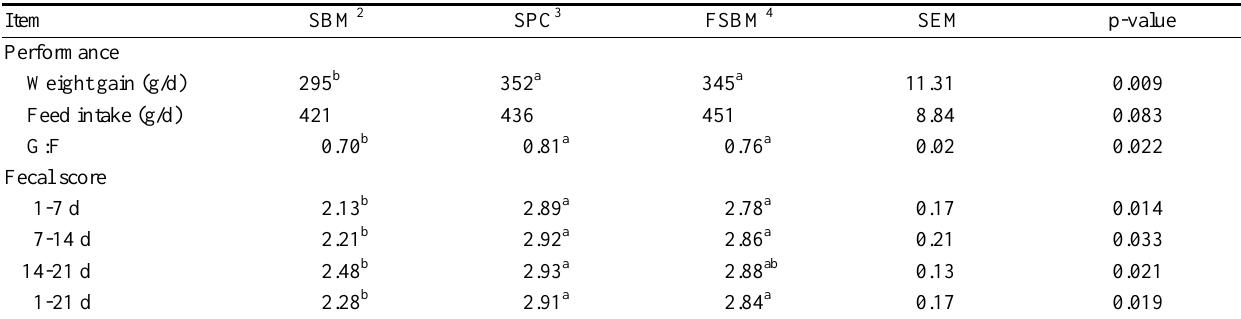
Table 7. Effects of same SID lysine:ME ratio (3.6 g/Mcal) diets containing soybean meal (SBM), soy protein concentrate (SPC) and fermented soybean meal (FSBM) on the performance of early-weaned piglets, Exp. 3 1